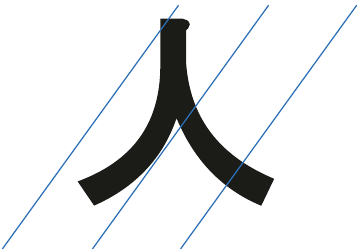
Figure 5: Horizontally inclined stroke density feature